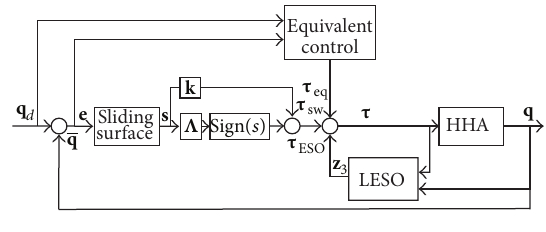
Figure 3: The block diagram of the SMC-ESO.